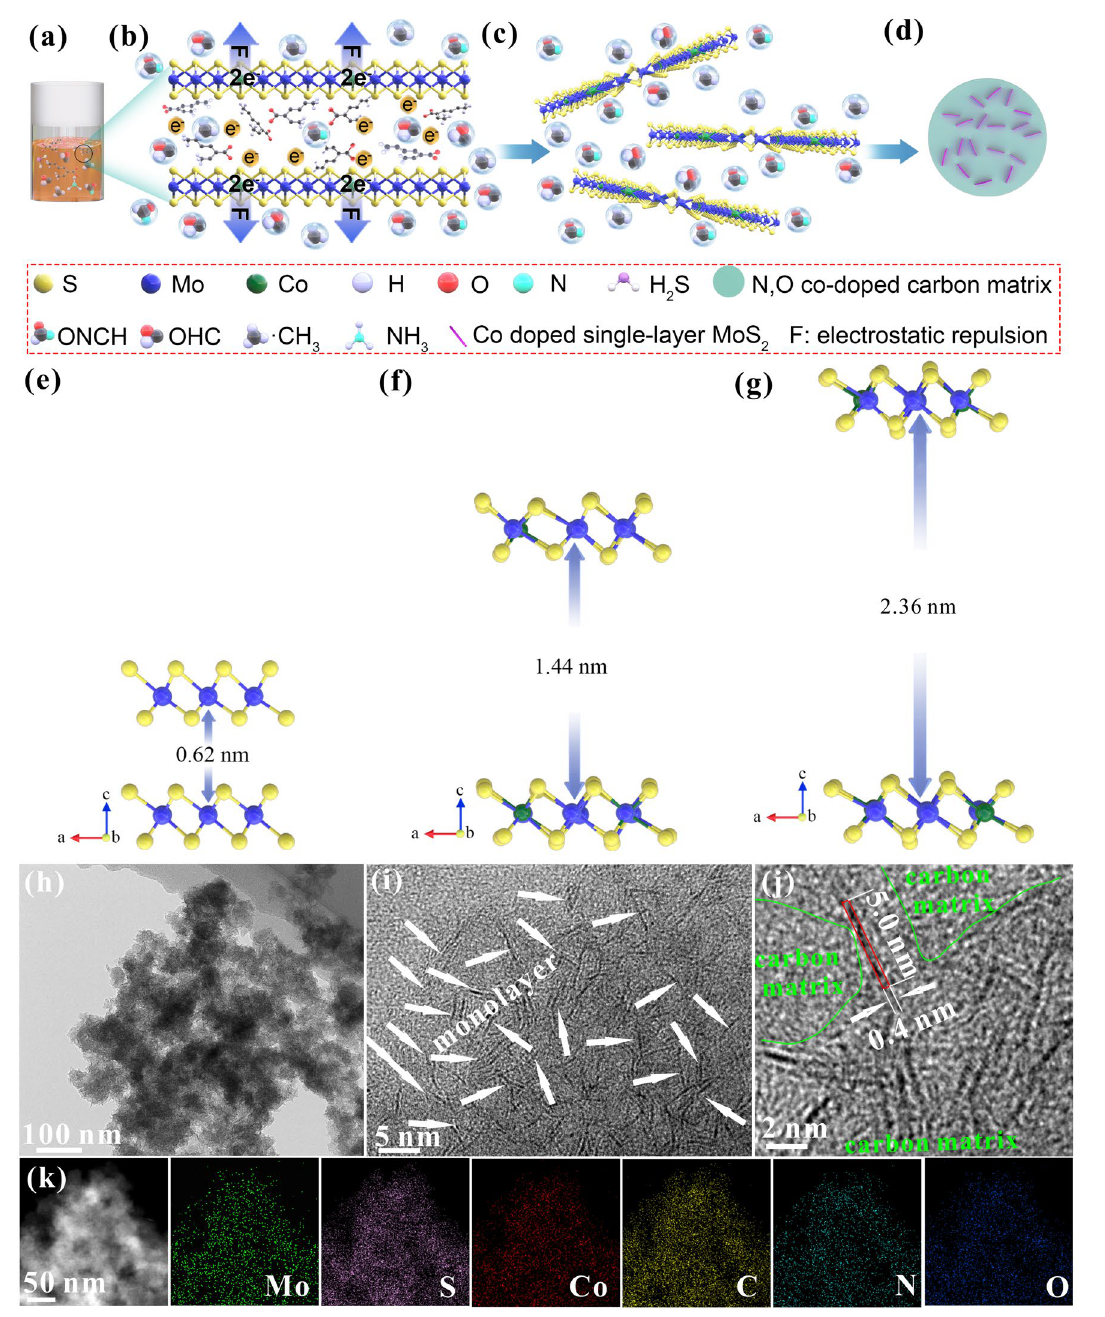
Fig. 1 a–d Schematic diagram of formation process of monolayer MoS 2 . DFT results of e pure MoS 2 , f Co-doped MoS 2 with a Co/Mo atomic ratio of 1/5, and g Co-doped MoS 2 with a Co/Mo atomic ratio of 1/2. h TEM image, i , j HRTEM images, and k HAADF and its EDS mapping images of CoMoS 2